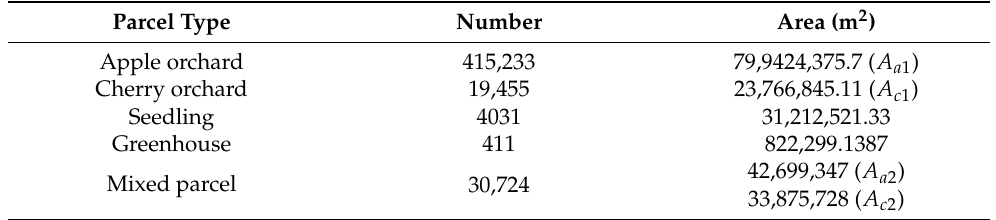
Table 5. Information obtained from different types of